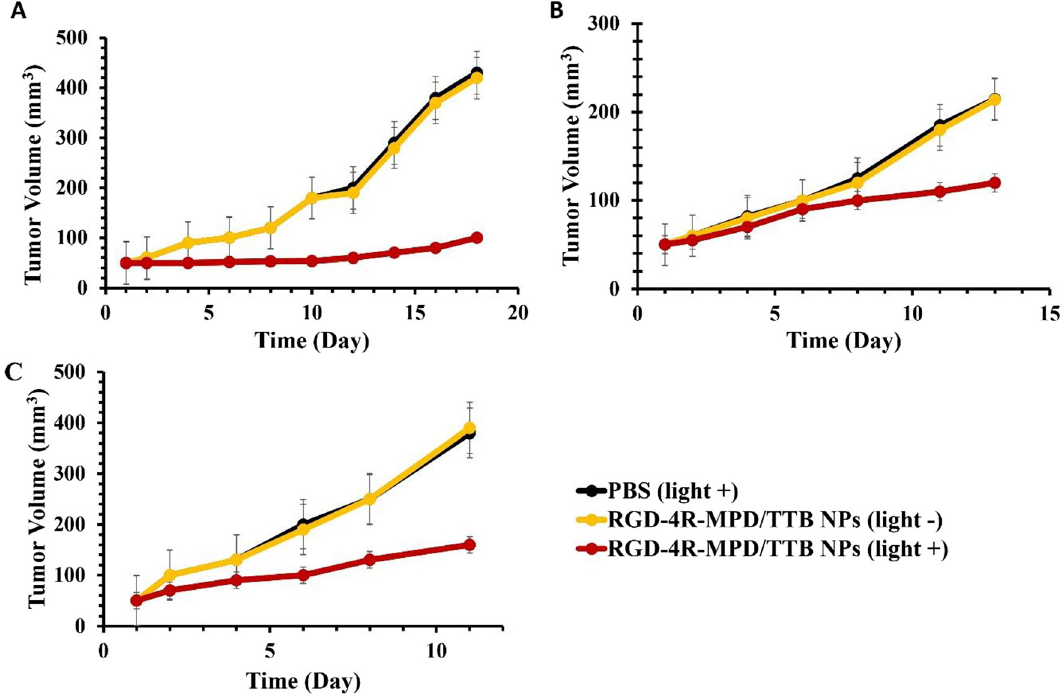
Figure 26: RGD-4R-MPD/TTB (10 μ g/mL) NPs mediated PDT for multiple xenograft